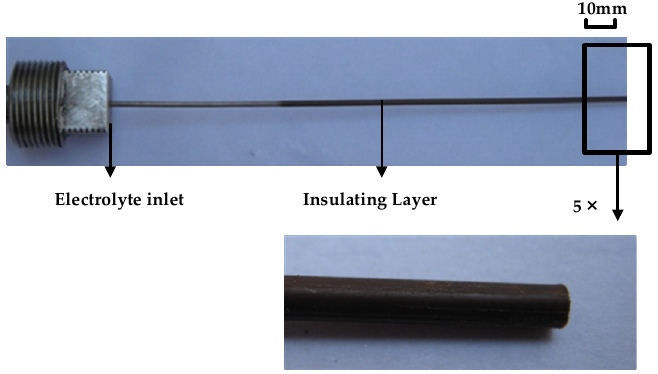
Figure 2. Titanium tube coated by tetrafluoroethylene.